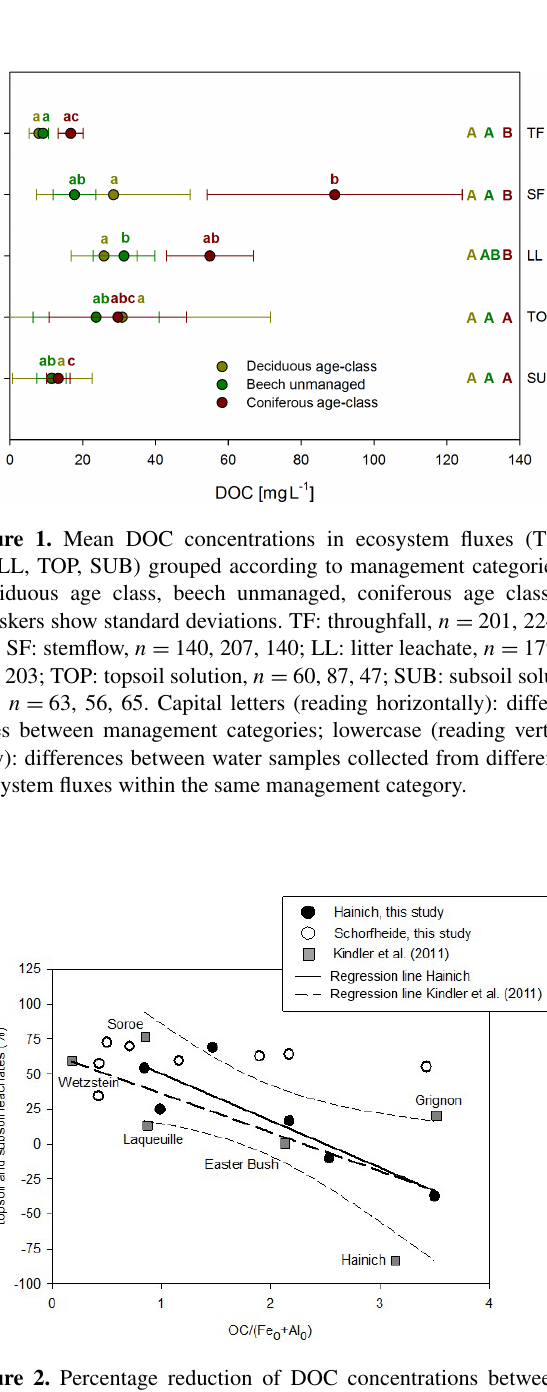
Figure 2. Percentage reduction of DOC concentrations between topsoil leachates (TOP) and subsoil leachates (SUB) in relation to the carbon saturation of pedogenic Fe and Al (hydr)oxides. For the Hainich sites of this study the reduction of DOC concentrations sig- nificantly decreases with increasing OC /( Fe 0 + Al 0 ) ratio (reduc- tion = 84%–34 · OC /( Fe 0 + Al 0 ) ; p = 0 . 027, R = 0 . 86). The rela- tive increase in DOC concentrations at high OC surface loadings was likely caused by a passive enrichment of remaining soil wa- ter with DOC due to water withdrawal by evapotranspiration. The names refer to the sites of the Kindler et al. (2011)